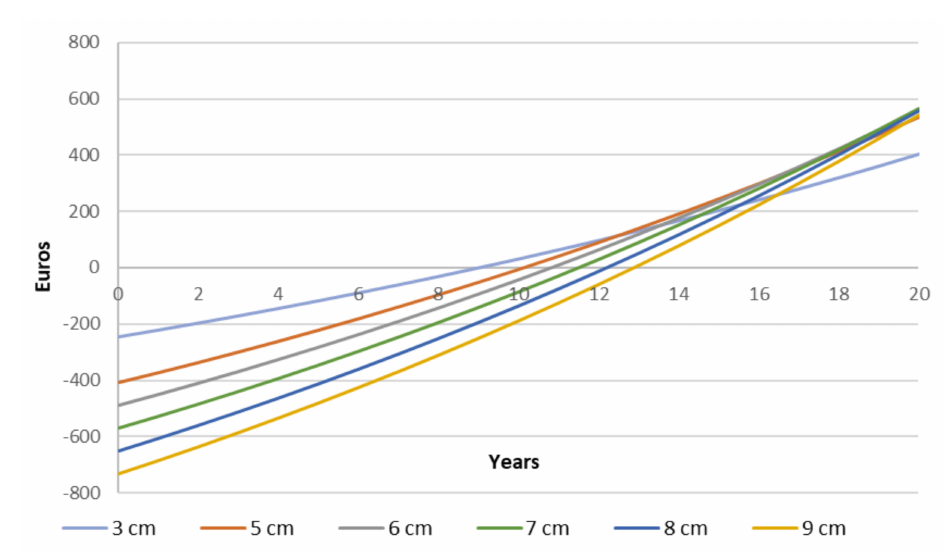
Figure 8. Cashflow analysis for different thicknesses of